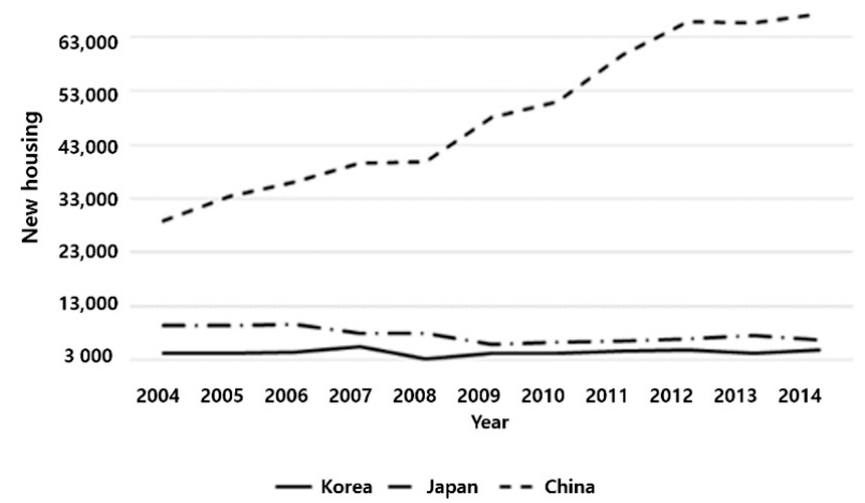
Figure 1. Number of new housing in Korea, China, and Japan [1].